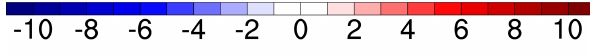
Figure 13. Maps of turnover-driven linearized equilibrium dead carbon changes after false priming effect has been removed, (cid:0) (cid:49)τ (cid:1) (cid:48) , for the fully coupled (1pctCO2) and radiatively × f d l → d, 0 coupled (esmFdbk1) experiments. False priming is removed by re- gressing the change in input-driven dead carbon against the change in turnover-driven dead carbon within the biogeochemically cou- pled (esmFixClim1) experiment, and then for each of the other two experiments, using this value to calculate a total false priming